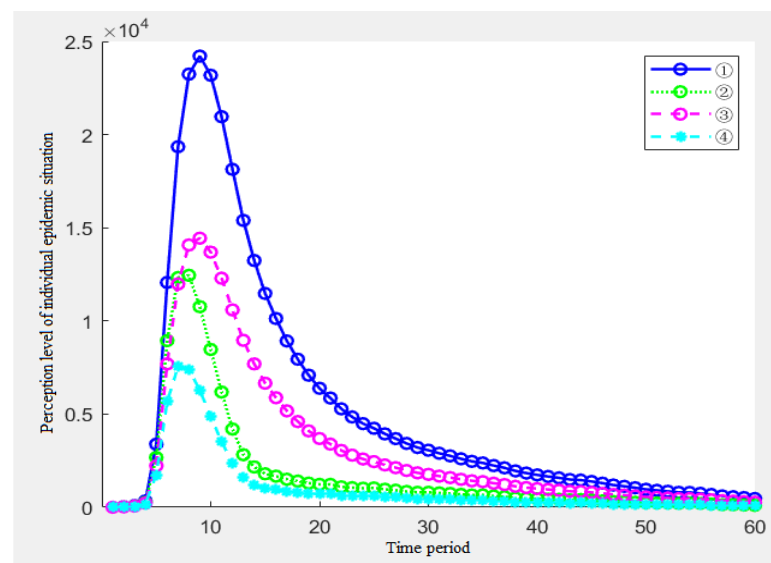
Figure 13. Risk perception changes from 27 December 2019 to 12 May 2021.